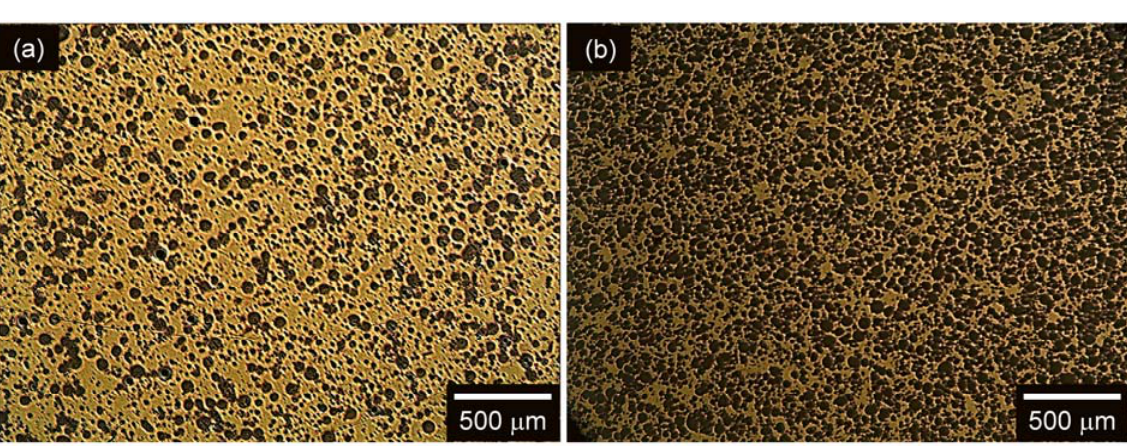
Figure 6. OM micrographs for the consolidated blended composites with ( a ) 40 vol.% and ( b ) 60 vol.% glass reinforcement.